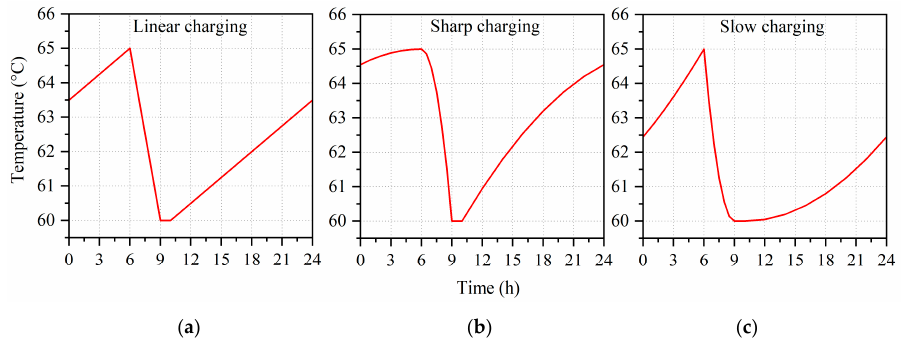
Figure 7. The flowchart of control algorithm for workdays.